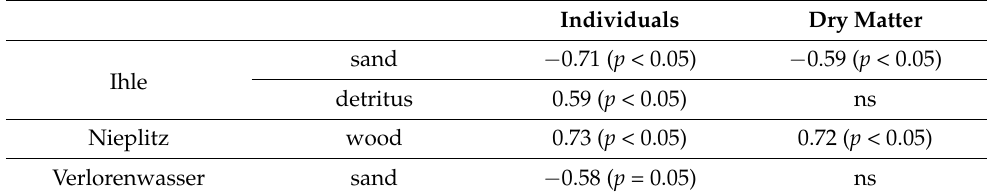
Table 3. Results of the correlation of the area percentages of the substrates with the density of individuals and the dry matter density of the MI ( n = 12; ns = not significant). Individuals Dry Matter sand − 0.71 ( p < 0.05) − 0.59 ( p < 0.05) Ihle detritus 0.59 ( p < 0.05) ns Nieplitz wood 0.73 ( p < 0.05) 0.72 ( p < 0.05) Verlorenwasser sand − 0.58 ( p = 0.05)